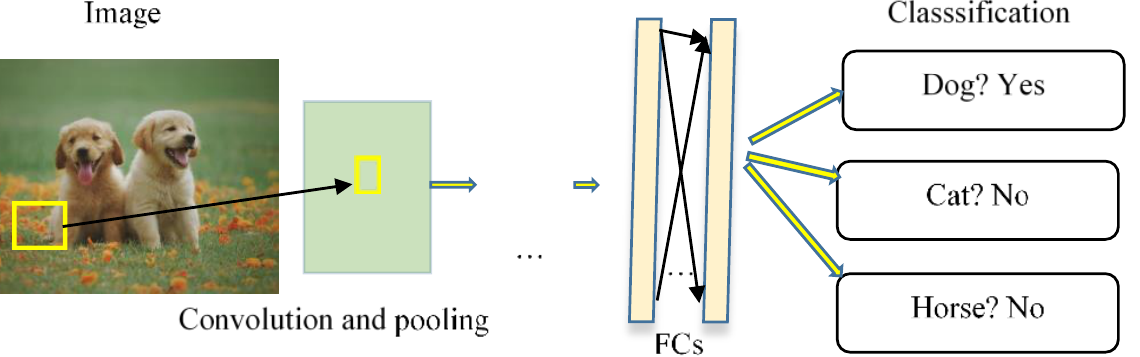
Figure 1. CNN architecture showing convolution layers and fully connected layers for image classification.